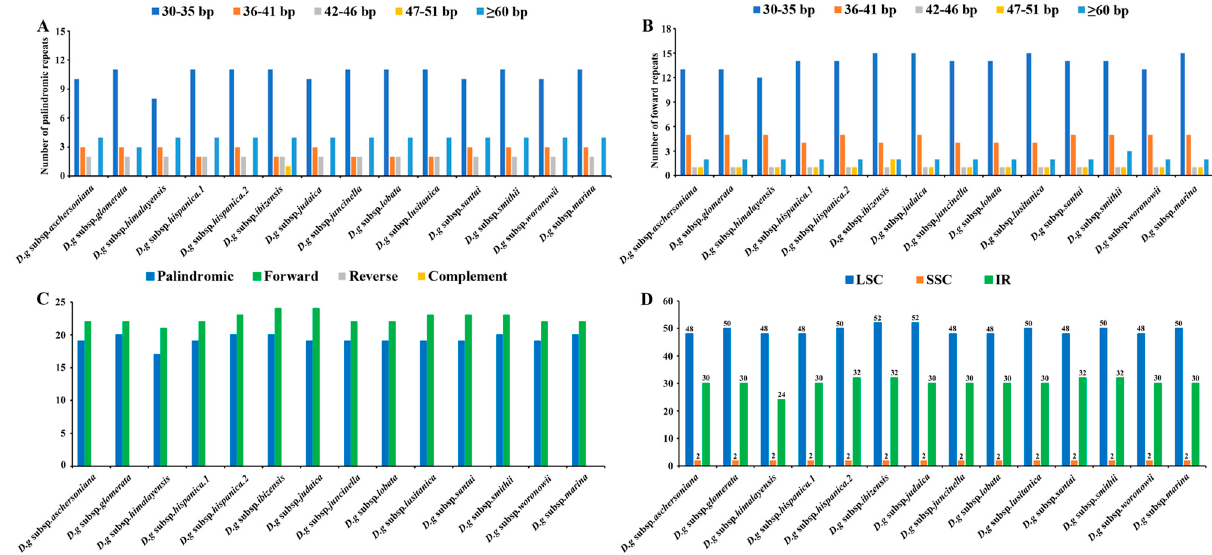
Figure 5. Analyses of repeated sequences in the cp genomes of 14 D. glomerata subspecies. ( A ) Number of palindromic repeats; ( B ) Number of forward repeats by length; ( C ) Number of different repeats; ( D ) Numbers of repeats in LSC, SSC and IR regions.